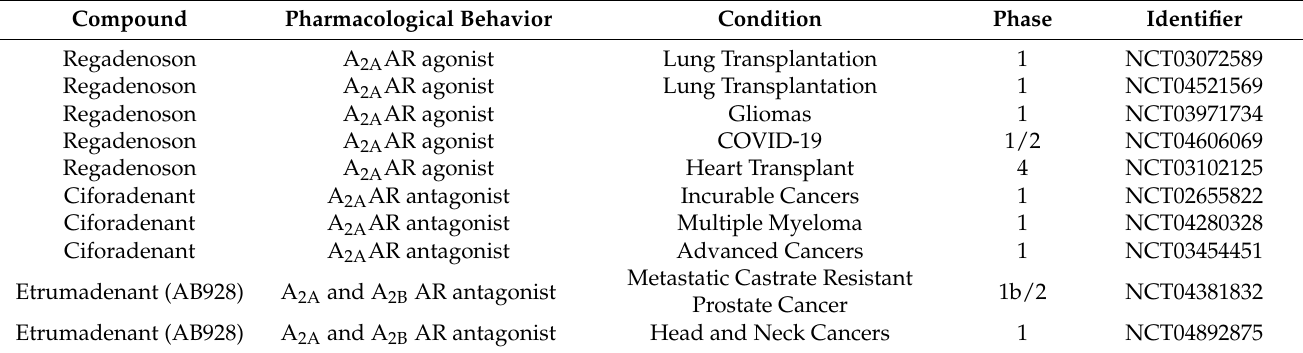
Table 1. Current clinical trials of AR ligands (data from ClinicalTrials.gov, accessed 15 July 2021).